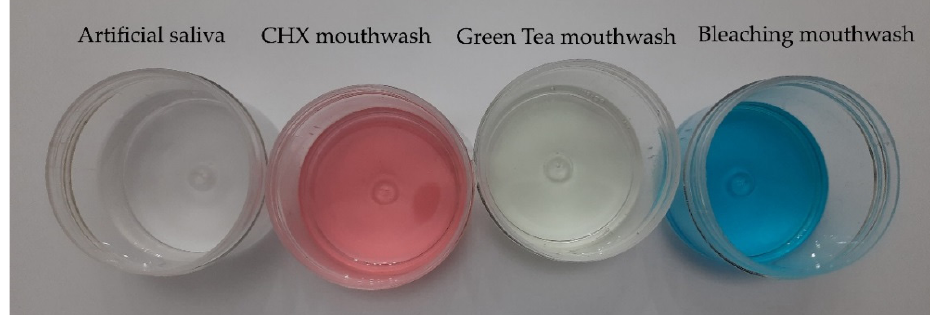
Figure 1. Artificial saliva and mouthwashes used in the study. Table 1. Ingredients of different studied materials.